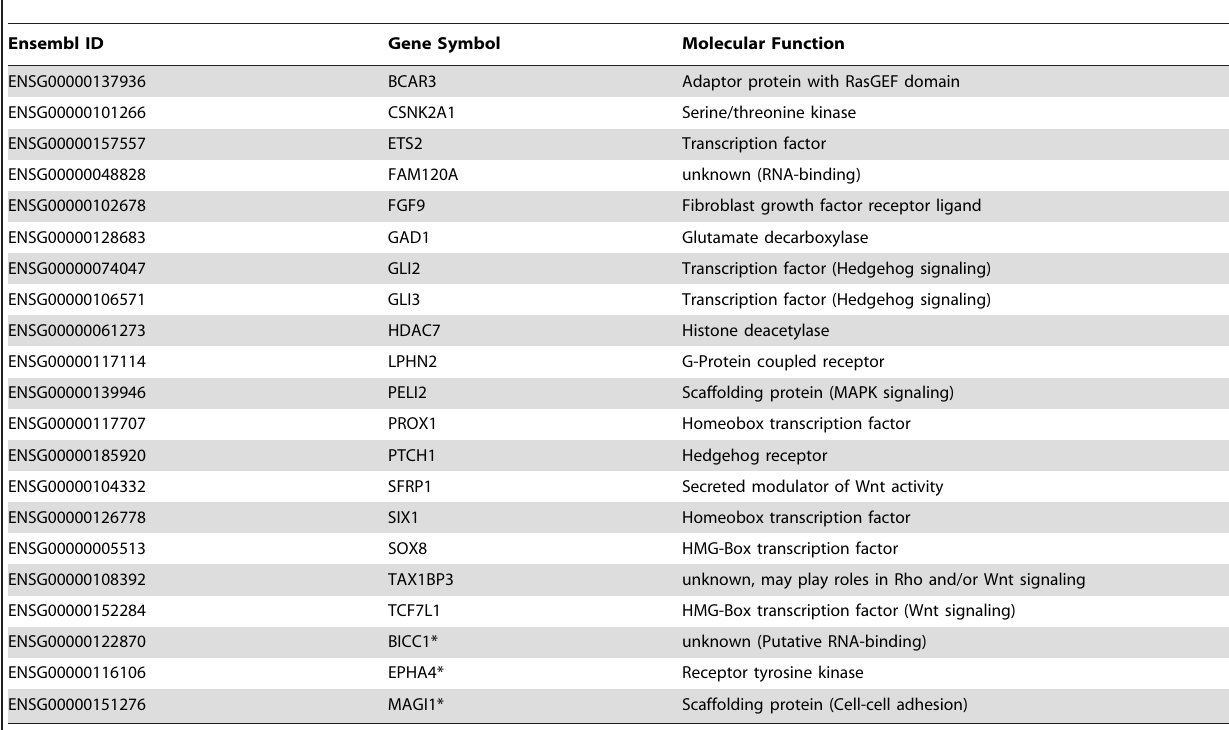
Table 1. Genes identified as positives in the RNA interference phenotypic screen in SW480 cells.